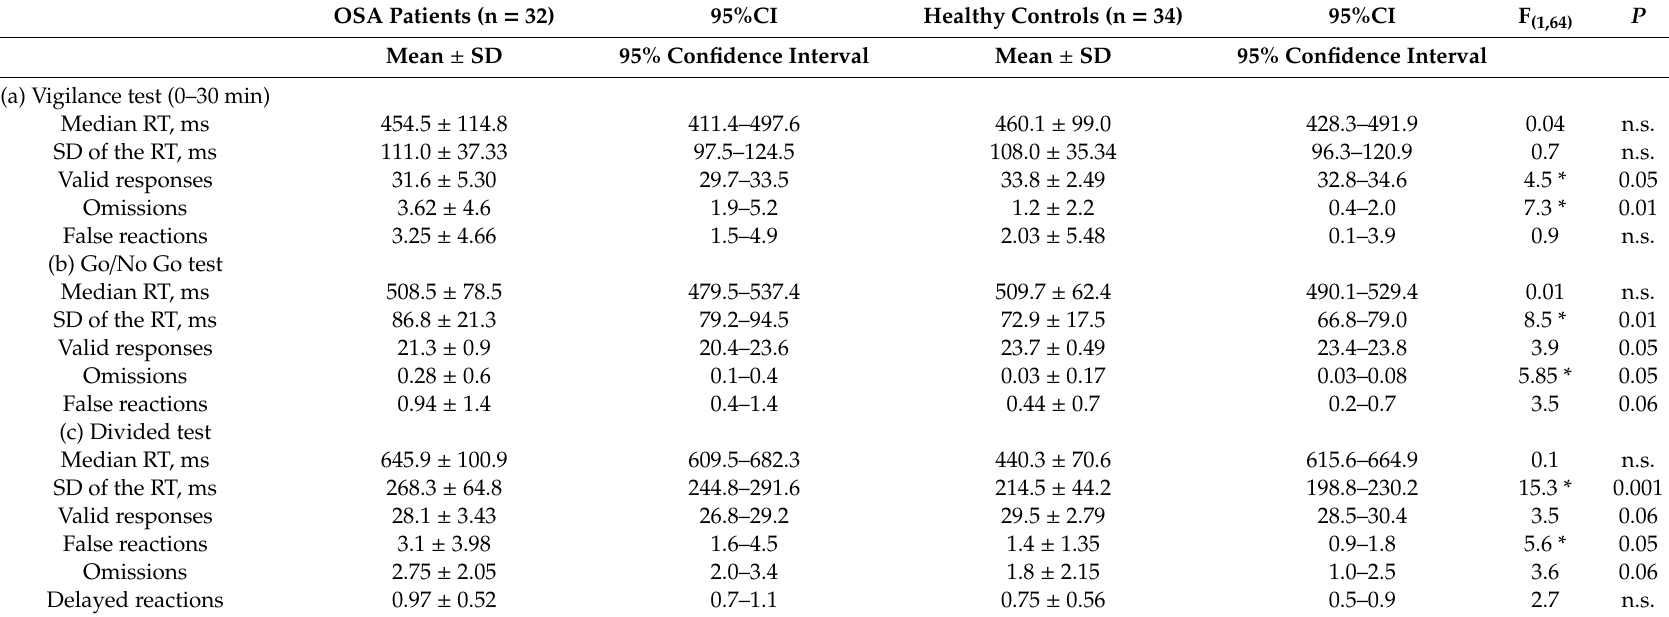
Table 6. Performance of OSA patients and healthy controls on the Test for Attention Performance